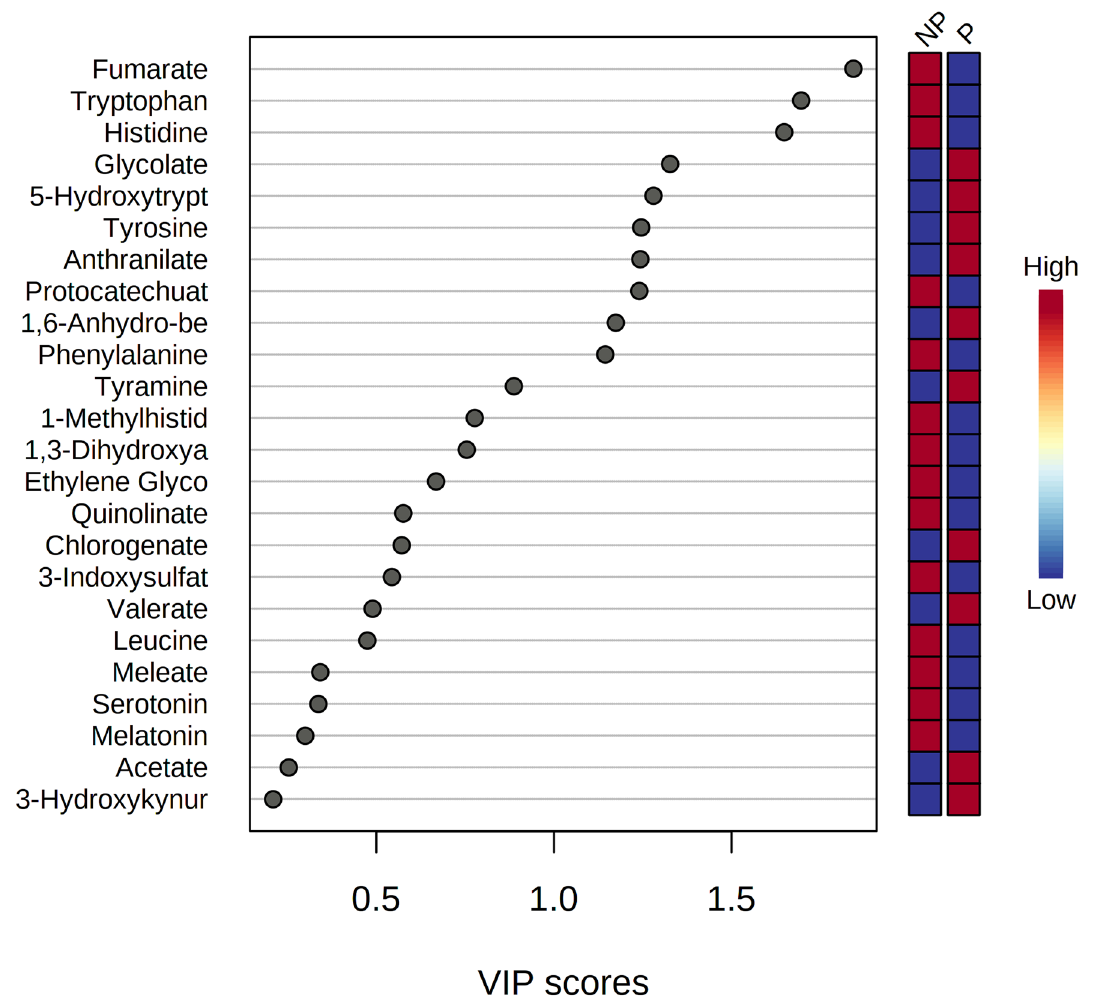
Figure 5. Variable Importance in Projection (VIP) score of the metabolites through OPLS-DA analysis; as potential early pregnancy detection biomarkers 5-hydroxytryptophan, Tyrosine and Anthranilate showed VIP score above 1 and depicted high abundance ratio in pregnant samples (corresponding